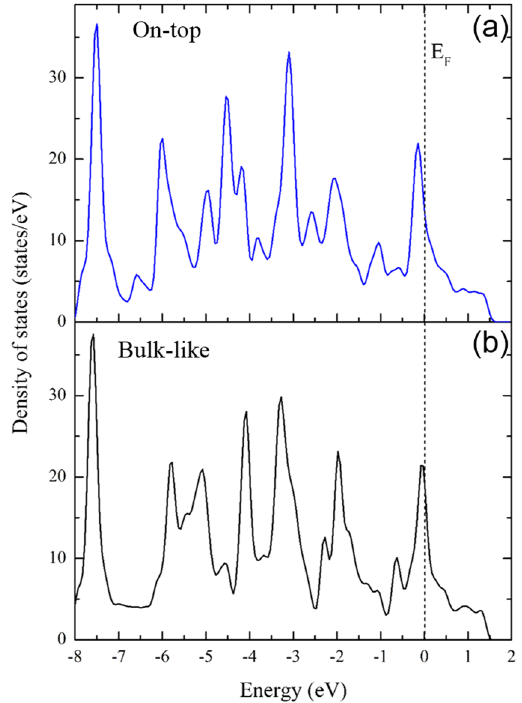
Figure 7. Density of states of ( a ) On-top and ( b) Bulk-like arrangements. Reference energy was set to the Fermi level position.